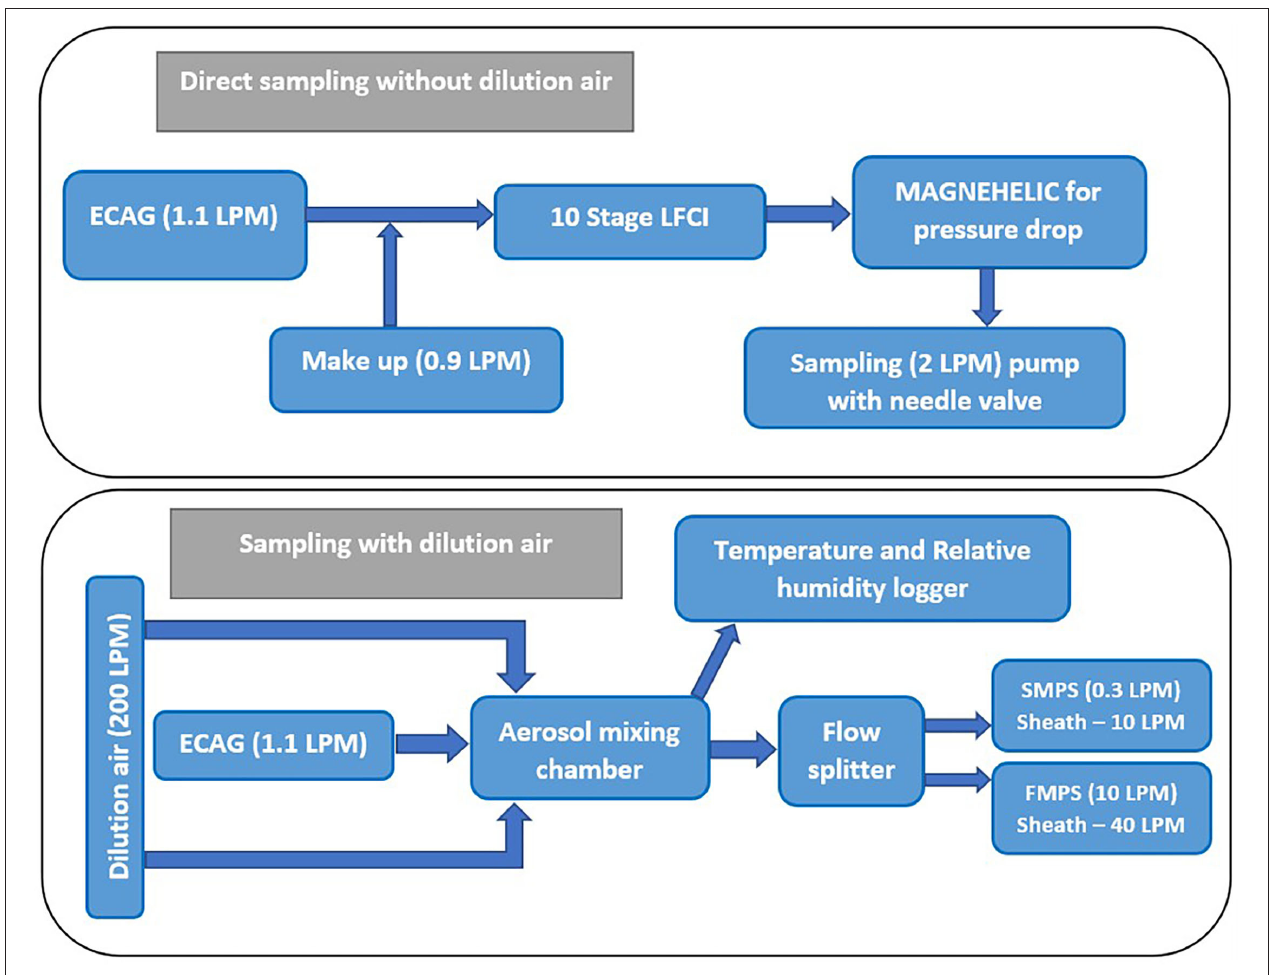
FIGURE 1 | Schematic of test system for measurement of e-liquid aerosol mass- (top) and number- (bottom) based particle size distributions. ECAG, e-cigarette aerosol generator; FMPS, fast mobility particle sizer; LFCI, low-flow cascade impactor; LPM, liters per minute; SMPS, scanning mobility particle